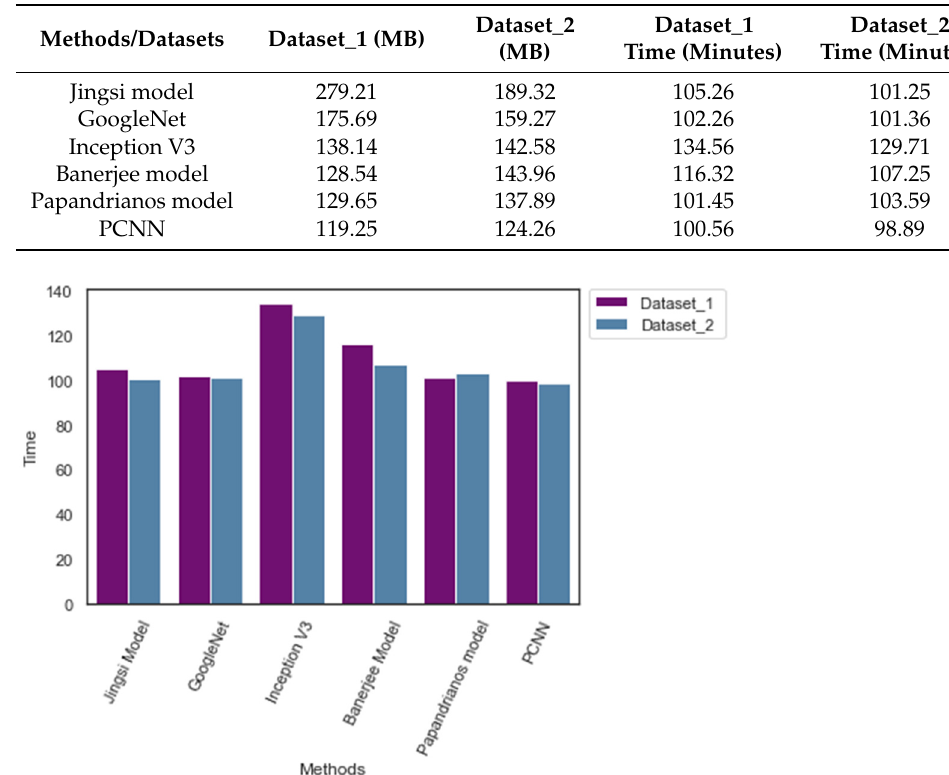
Table 9. Memory sizes of CNN for Dataset_1 and Dataset_2.